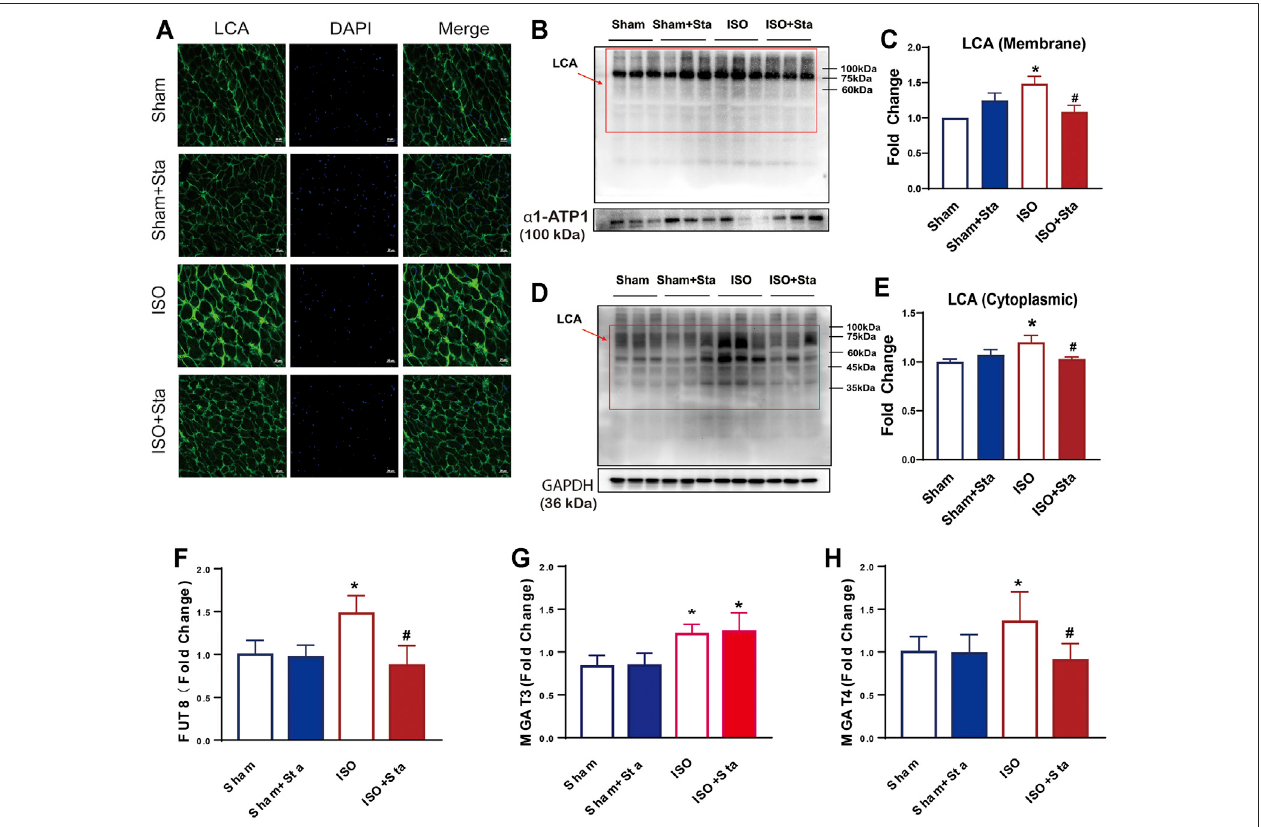
FIGURE 9 | Stachydrine hydrochloride inhibits the expression of FUT8 and MAGT4a to reduced α -1,6-fucosylation. (A) Images of FITC-labeled Lens culinaris agglutinin (LCA) lectin af fi nity fl uorescence histopathology sections. (B – E) Representative Western blot and quanti fi cation of LCA exposed to ISO at 2 weeks on the cell membraneandincytoplasmic. (F – H) FUT8,MGAT3,andMGAT4aexpressionmeasurementwithELISAkits. n =5miceperexperimentalgroup.Thedataareexpressed as mean ± standard error of mean, * p < 0.05 versus Sham; # p < 0.05 versus ISO. FUT8, α -1,6-fucosyltransferase; LCA, Lens culinaris agglutinin; MGAT3, β -1,4- mannosylglycoprotein 4- β -N-acetylglucosaminyltransferase; MGAT4a. α -1,3-mannosyl-glycoprotein 4- β -N-acetylglucosaminyltransferase A; ISO, isoproterenol; Sta, stachydrine hydrochloride.